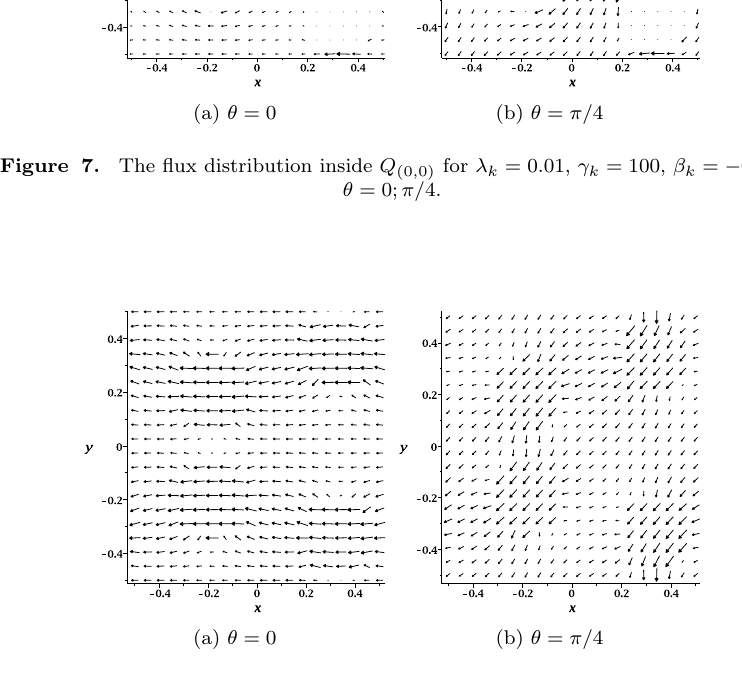
Figure 8. The flux distribution inside Q (0 , 0) for λ k = 100, γ k = 100, β k = − 0 . 01, θ = 0; π/ 4.